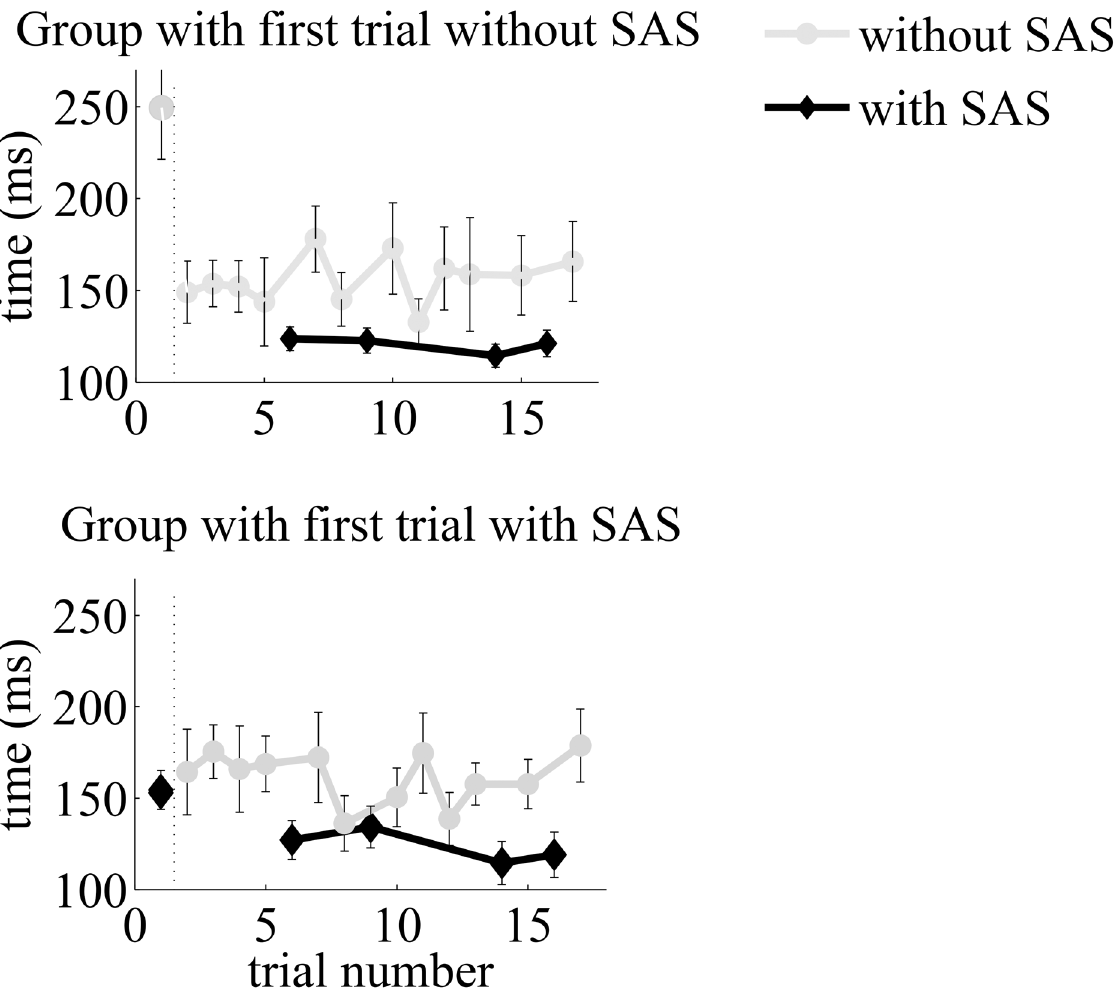
Fig 2. Mean onset latencies per trial during the simple reaction time task with voluntary ankle dorsiflexion. Gray lines are trials without a SAS, black lines are trials with a SAS. The error bars indicate standard errors.